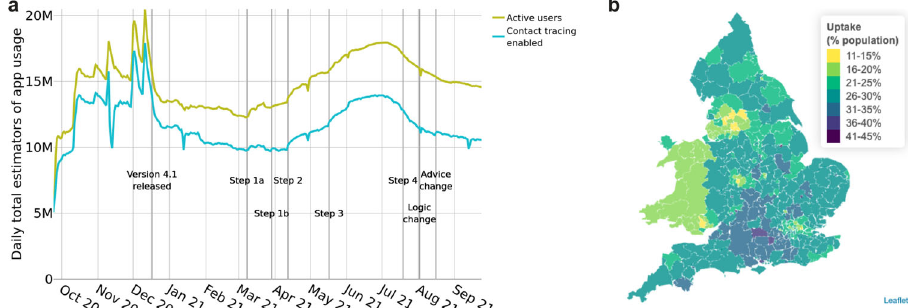
Fig.1|Appusage.a ThenumberofactiveappusersacrossEnglandandWales,andthenumberofdeviceswithBluetoothcontacttracingenabled. b AppuptakeperLTLA, estimated as the mean number of active users as a proportion of the total population.